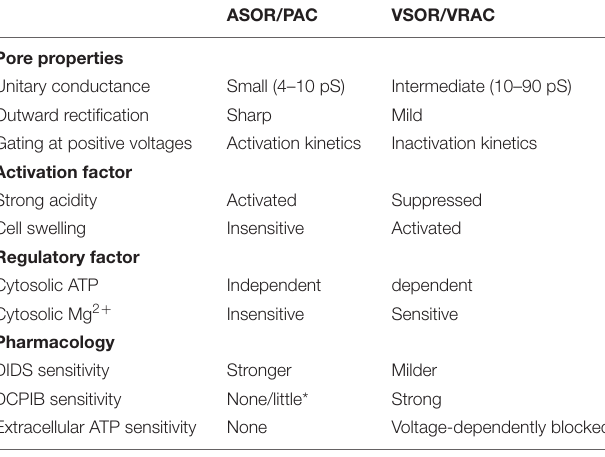
TABLE 2 | Comparison of properties of ASOR/PAC and VSOR/VRAC channel